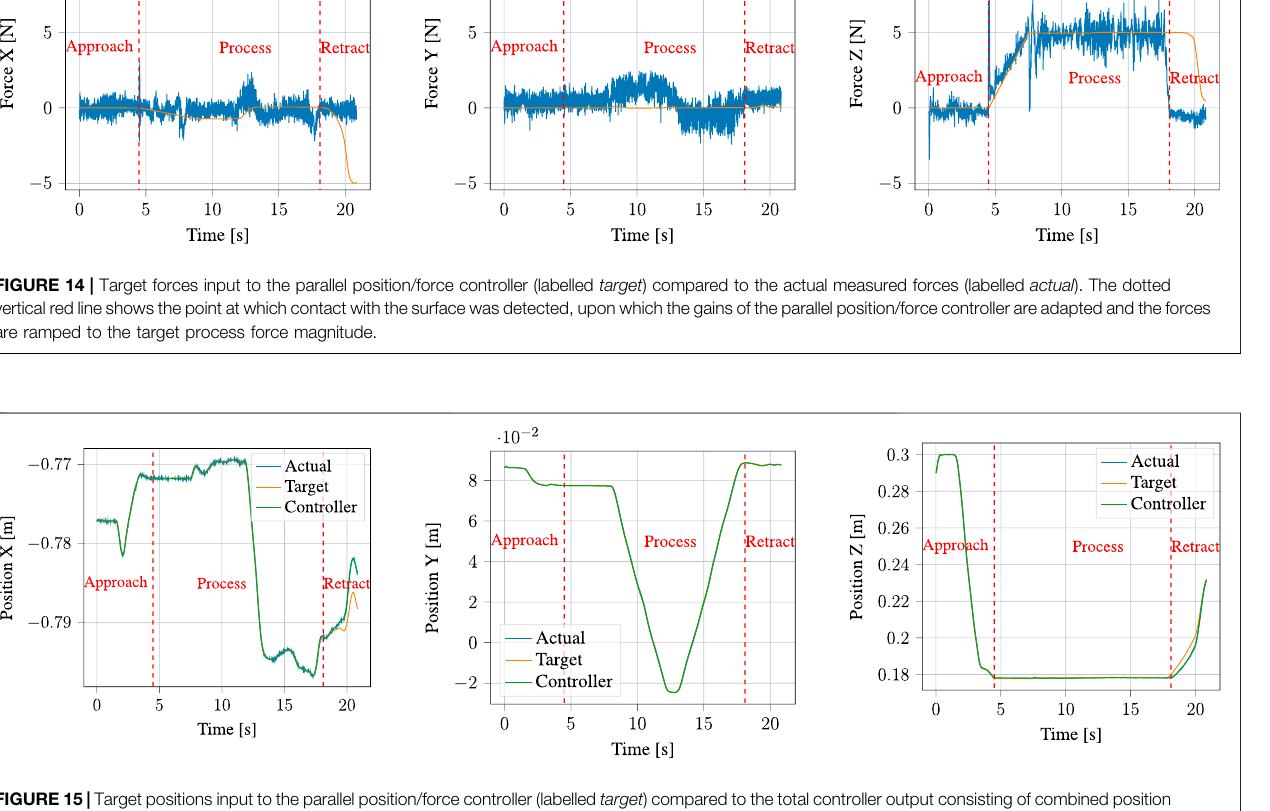
Frontiers in Robotics and AI |